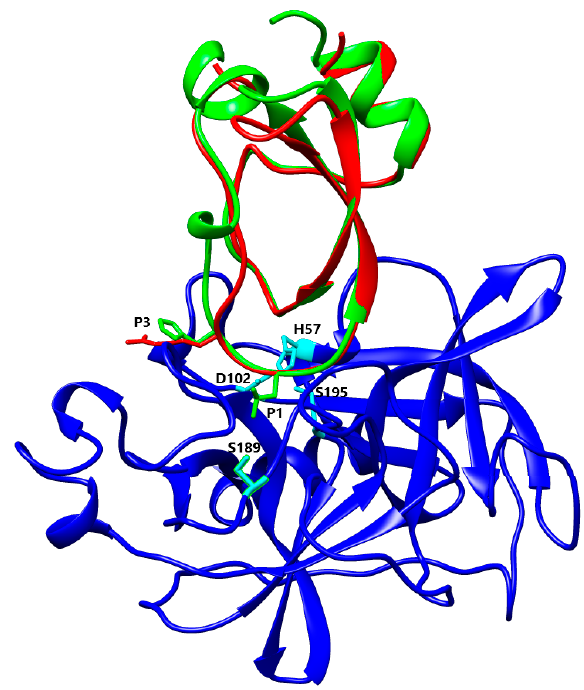
Figure 9. Alignment between Kun_Myl-35212_i1 and ShPI-1 K13L mutant/pancreatic elastase structures (PBD Code 3UOU) [52]. Blue, Elastase with catalytic residues (His57, Asp102, Ser189, and Ser195) in cyan stick representation; red, ShPI-1; green, Kun_Myl-35212_i1 with P1 (Leu13, green) and P3 (Arg11 for ShPI-1 and H11 for Kun_Myl-35212_i1 red and green, respectively) in stick representation. Although it displays 41% sequence similarity with the TFPI (Tissue Factor Pathway Inhibitor), it seems far from being a canonical serine protease inhibitor, given the presence of a negatively charged residue at the P1 position.